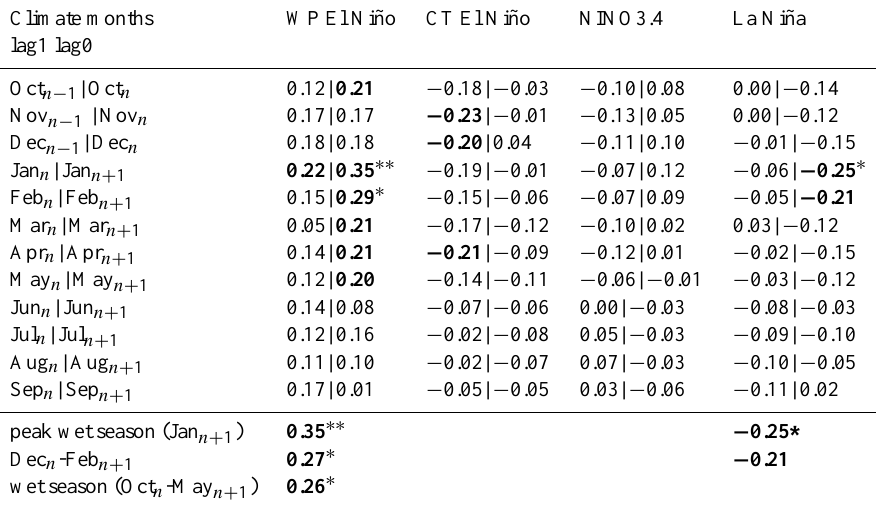
Table 2. Correlation values between the annually resolved δ 18 O TR record and climate months of different ENSO flavors and the standard NINO3.4 and La Niña index (NINO4 × ( − 1)) for the period from the year prior to growth (lag-1) to the current year (lag-0) and seasonal means (calculated over the 1900–2007 period). ( ∗∗ p < 0 . 001, ∗ p < 0 . 01, bold: p < 0 .